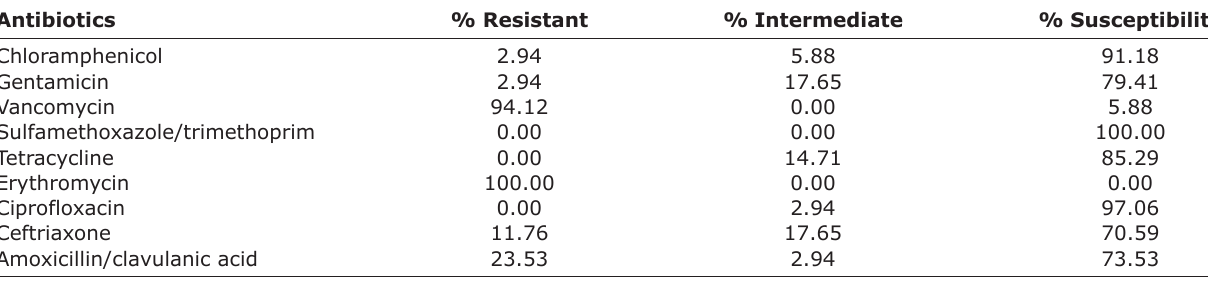
Table-2: Antibiotic susceptibility of drinking water Salmonella isolates.